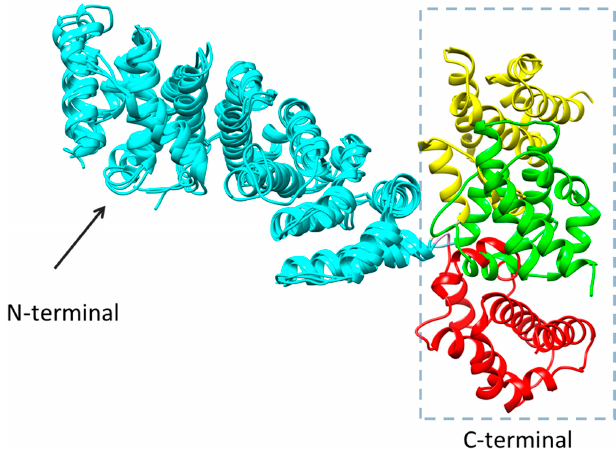
Figure 8. The X-ray crystallographic structures of yeast V-ATPase subunit H from the RCSB Protein Data Bank (PDB entry code: 1ho8, 5vox, and 5d80). All proteins are shown in cartoon model. N-terminals of all proteins are colored in cyan. C-terminals of the proteins are colored in yellow (1ho8), green (5vox), and red (5d80) respectively.